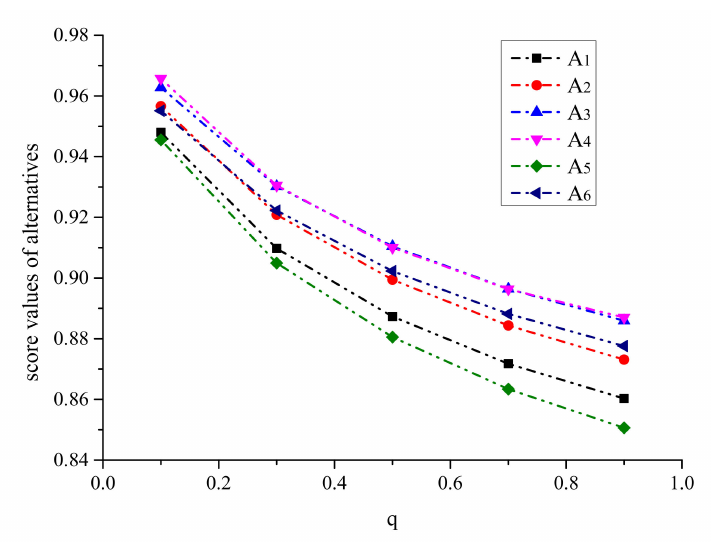
Figure 9. Alternatives ranking with p = 2 and q ∈ [ 0.1,0.9 ]